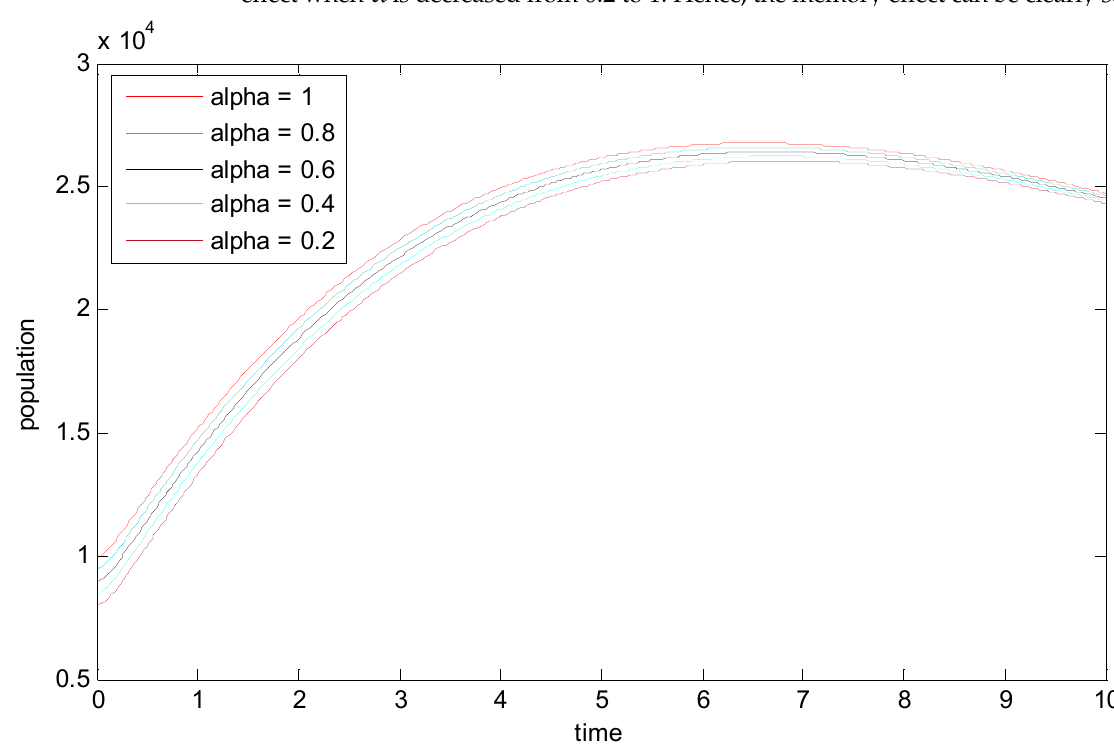
Figure 7. Dynamics of the infected population for various values of α .